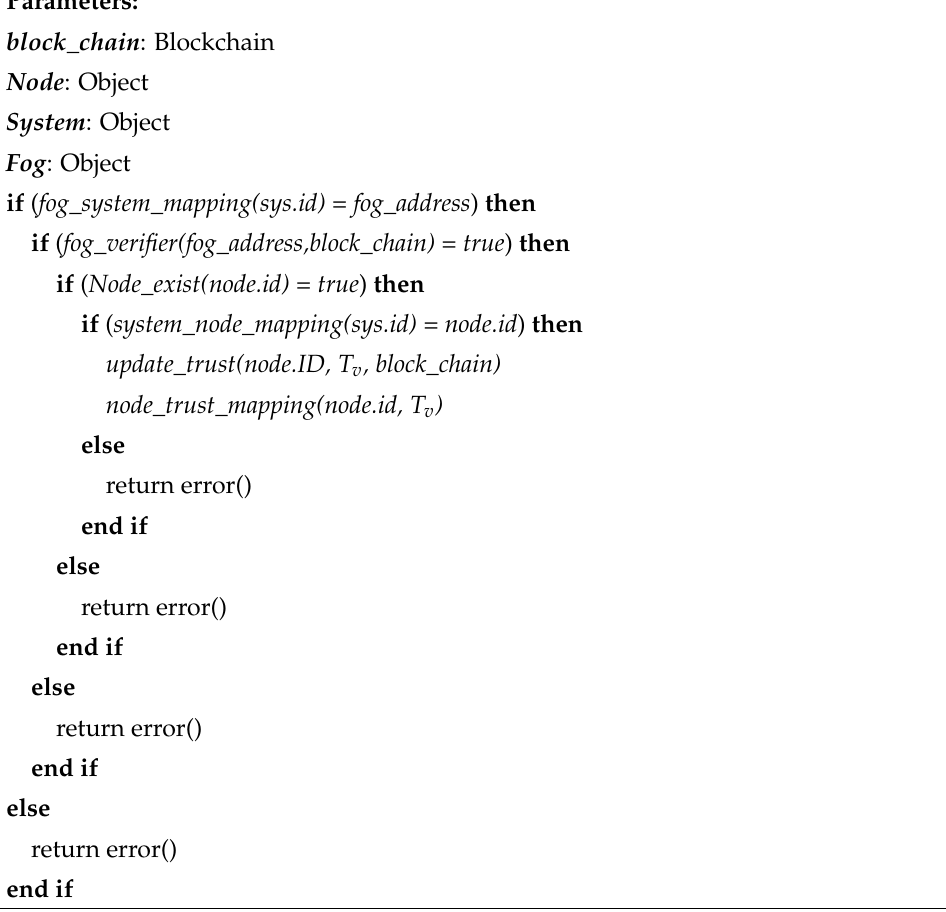
Algorithm 3 Device trust insertion and update rules for smart